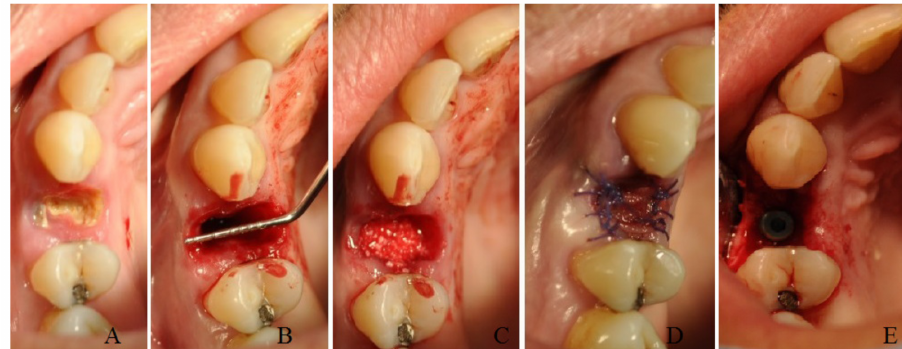
Figure 3. A case of socket preservation performed with autologous bone harvested from the mandible placed inside the alveolar socket covered with a resorbable collagen matrix and the insertion of the dental implant after four months: preoperative image with decayed root ( A ); image after root extraction ( B ); image of socket filled with autologous bone graft ( C ); suture and collagen matrix ( D ); image at the time of implant surgery, with detail of cap screw ( E ).